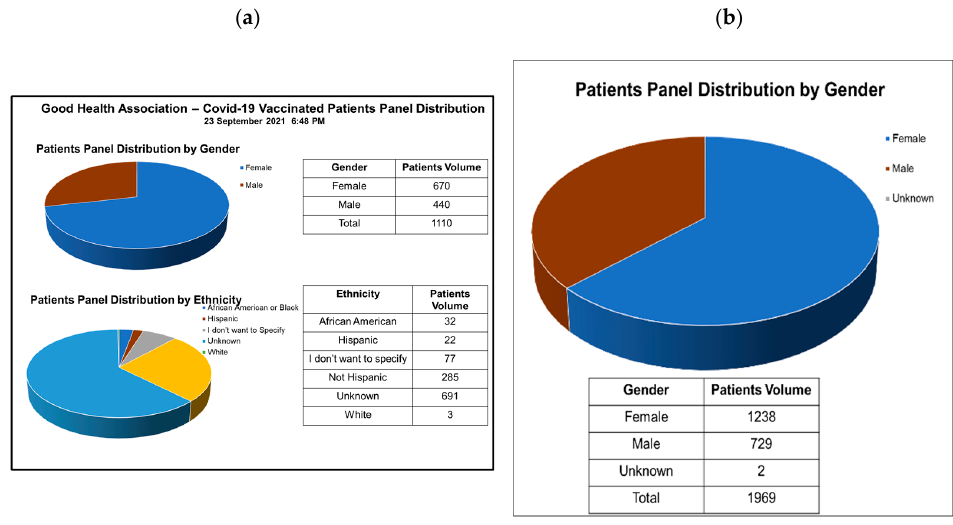
Figure 4. Patients panel distribution and vaccination: ( a ) by gender; ( b ) by ethnicity .